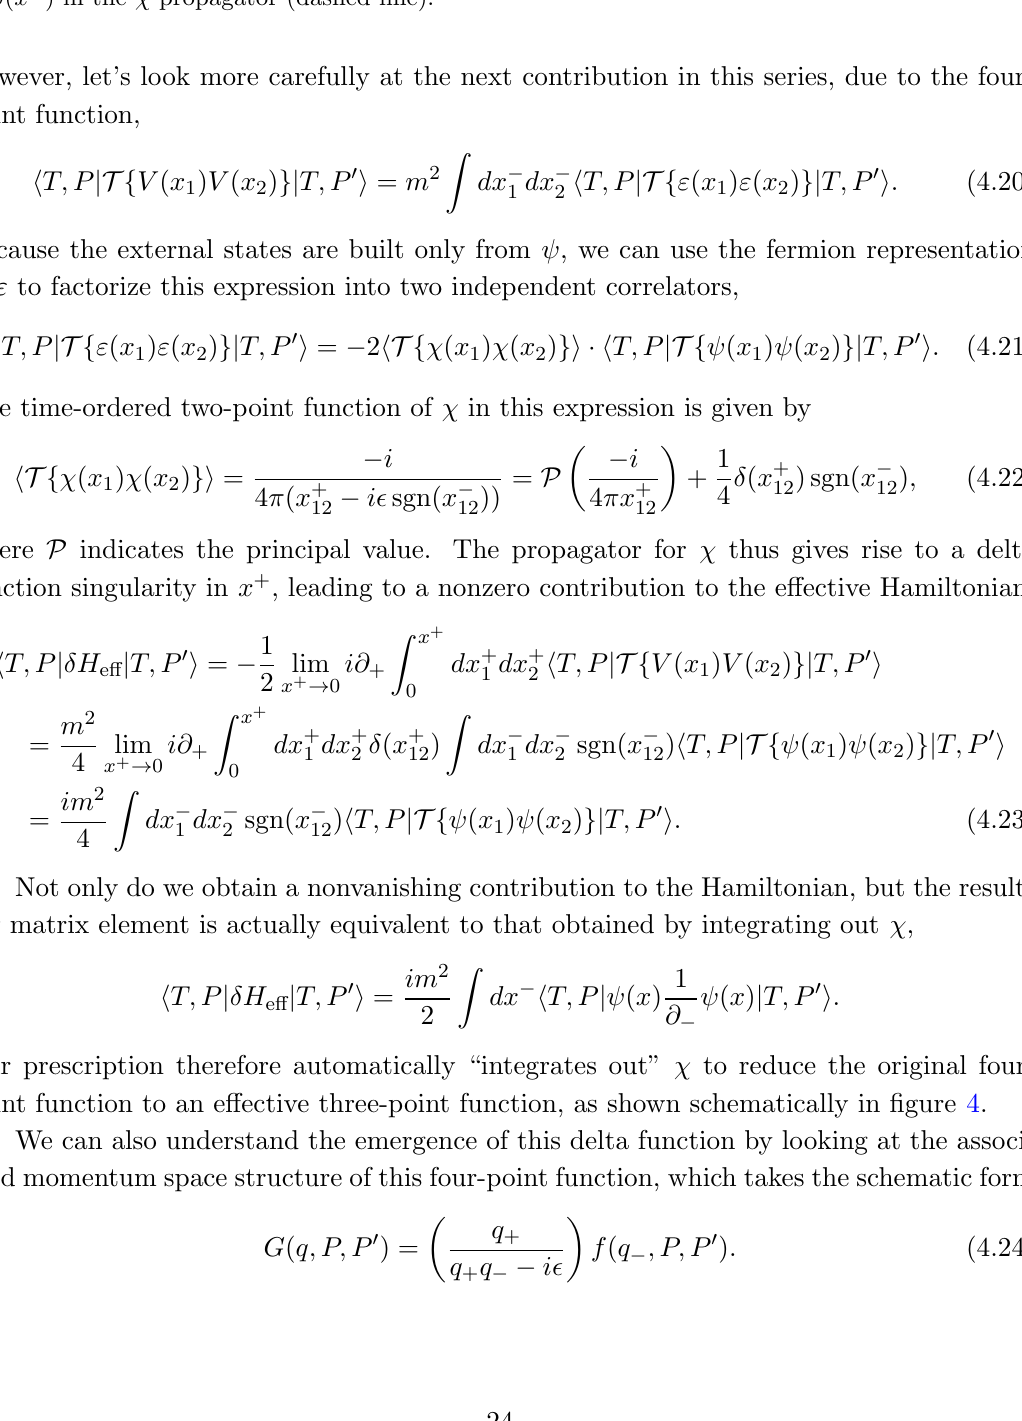
T""T gives rise to a Hamiltonian h i . This contribution arises due to the factor @